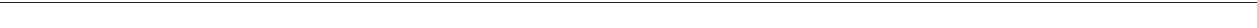
Fig. 7 RELB binds SMAD proteins and is recruited by SMAD(s) to promoters. a HEK293T cells were co-transfected with plasmids expressing myc-RELB and epitope-tagged SMAD proteins for 36 h. Cells were crosslinked and immunoprecipitated (x-link IP) using anti-myc antibodies. b A549 cells were stably transduced with control non-targeting shRNA (shCtrl) or shRNA targeting SMAD4 (sh SMAD4 ). Immunoblotting was performed to con fi rm selective SMAD4 knockdown ( upper right panel ) and cells were subjected to ChIP analysis with RELB and SMAD4 antibodies (IgG, rabbit IgG negative control antibody). Promoter identities are above charts. Precipitating DNA abundance is expressed as a percentage of input (means, n = 3, ± S.D., * P < 0.05 or ** P < 0.01 sh SMAD4 vs. cognate shCtrl IP, two-tailed t -test). c ChIP was performed using A549 cells, with or without prior treatment for 16 h with 5 ng/ml TGF β 1, using the antibodies indicated (IgG control or RELB). Promoter sequences analysed are given below (means, n = 3, ± S.D., ** P < 0.01, two-tailed t -test, negative ctrl = non-SMAD binding CANX promoter). d A549 cells were stably transduced with control non-targeting shRNA (shCtrl) or shRNA targeting SMAD3 (sh SMAD3 ). Immunoblotting was performed to con fi rm selective SMAD3 knockdown and cells were subjected to ChIP analysis with RELB antibody (IgG, rabbit IgG negative control). Promoter identities are above the charts. Precipitating DNA abundance is expressed as a percentage of input (means, n = 3, ± S.E.M., # P > 0.05 vs. cognate shCtrl IP, two-tailed t -test). e A549 cells analysed by re-ChIP to detect mutual binding of RELB and SMAD4 to promoters. The fi rst round (initial ChIP) antibody (IgG or SMAD4) is indicated below the plots and the second round (re-ChIP) antibody (IgG, RELB or SMAD4) is shown in the colour key. Promoter identities are above individual plots (means, n = 3, ± S.D., * P < 0.05 or ** P < 0.01 vs. cognate IgG in second round of ChIP, two-tailed t -test). f A549 WT and Δ ATG5 cells were subjected to ChIP with IgG or RELB antibodies (means, n = 3, ± S.D., * P < 0.05 or ** P < 0.01, two-tailed t -test). Uncropped blots are available in Supplementary Fig.